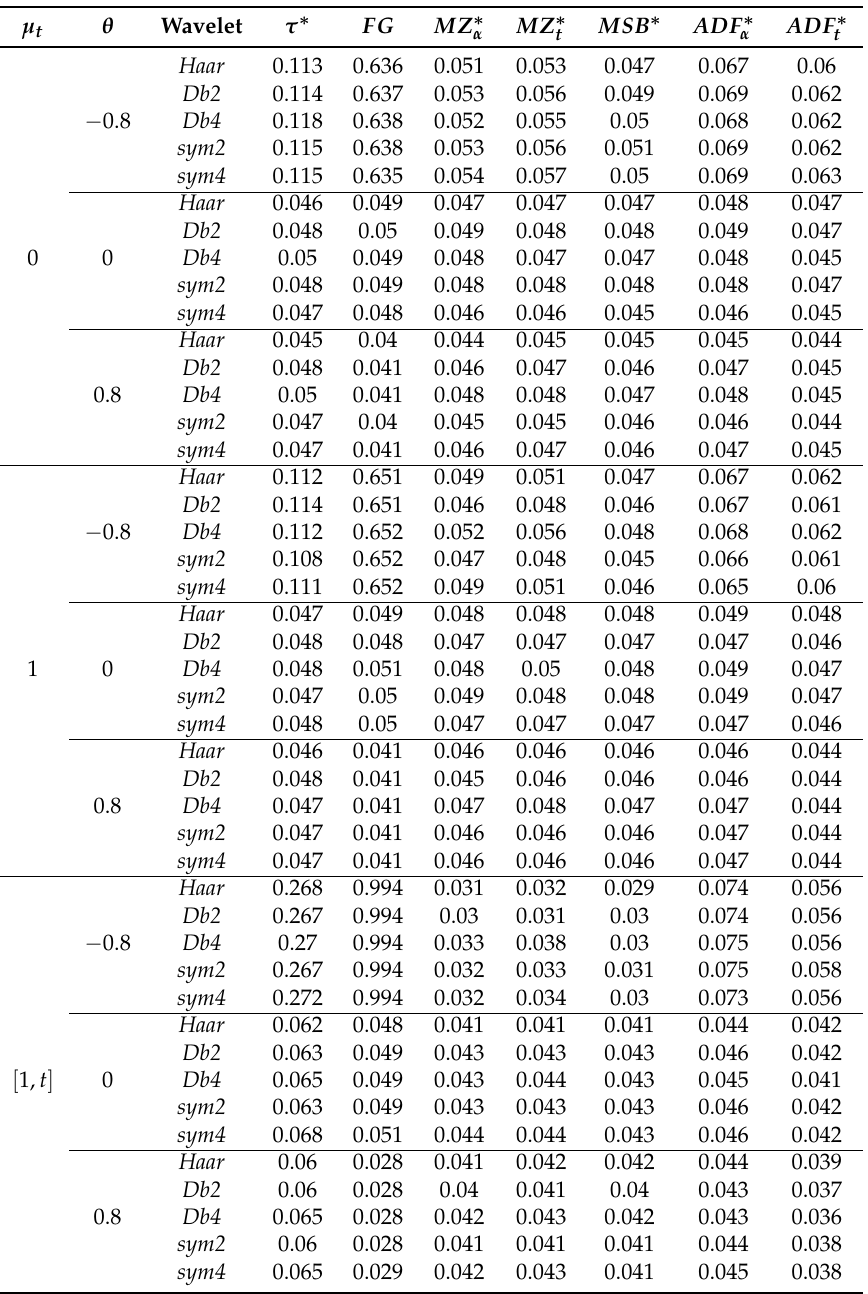
Table 3. The empirical size of wavelet based tests with sample size =